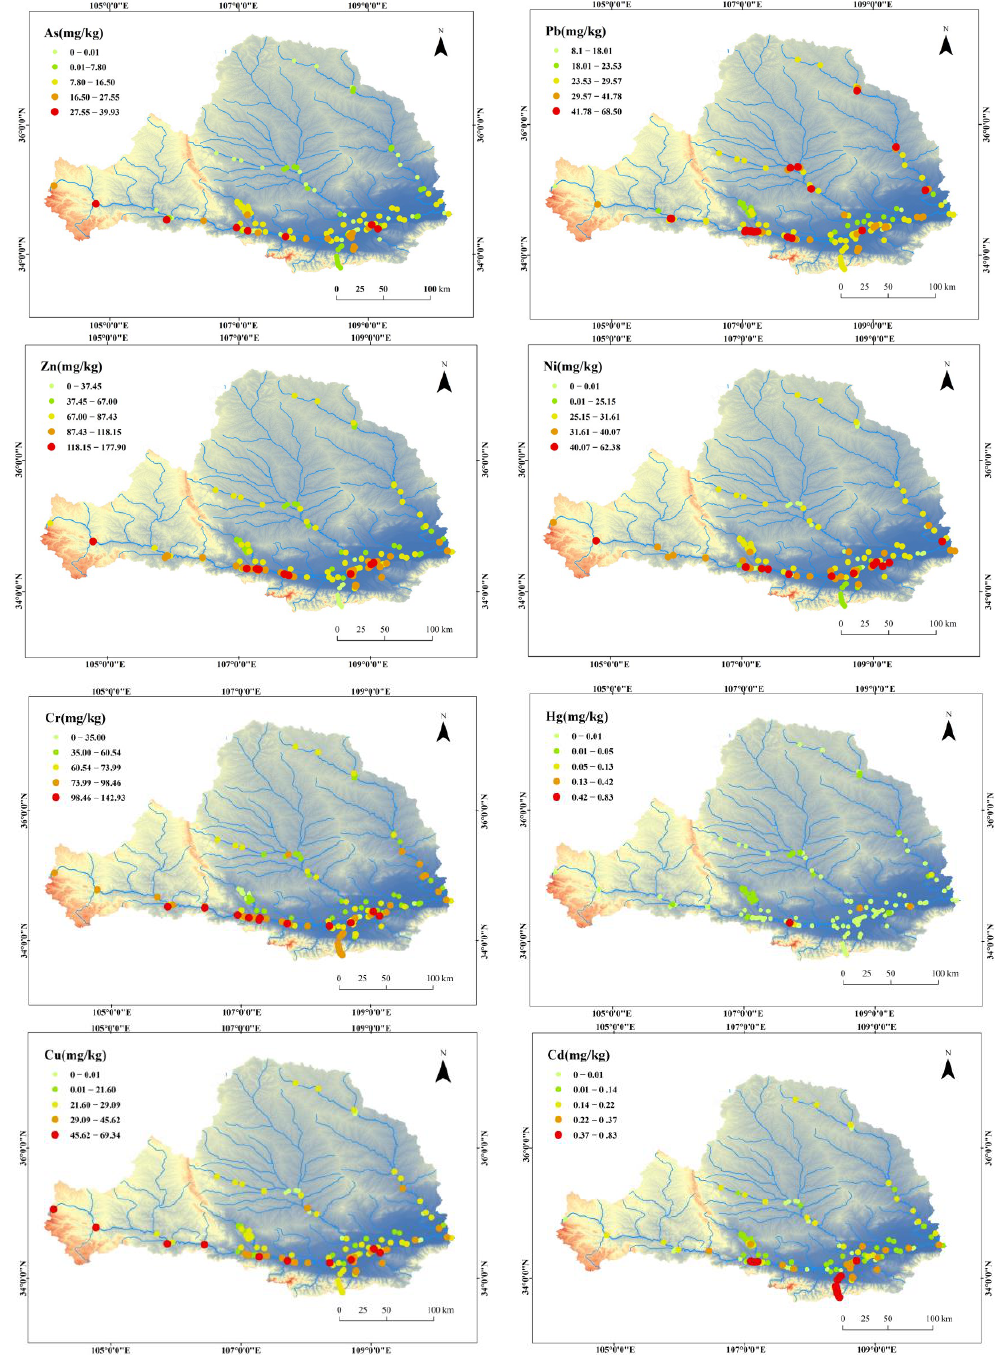
Figure 3. Spatial distribution of heavy metals in sediments of Weihe River Basin.